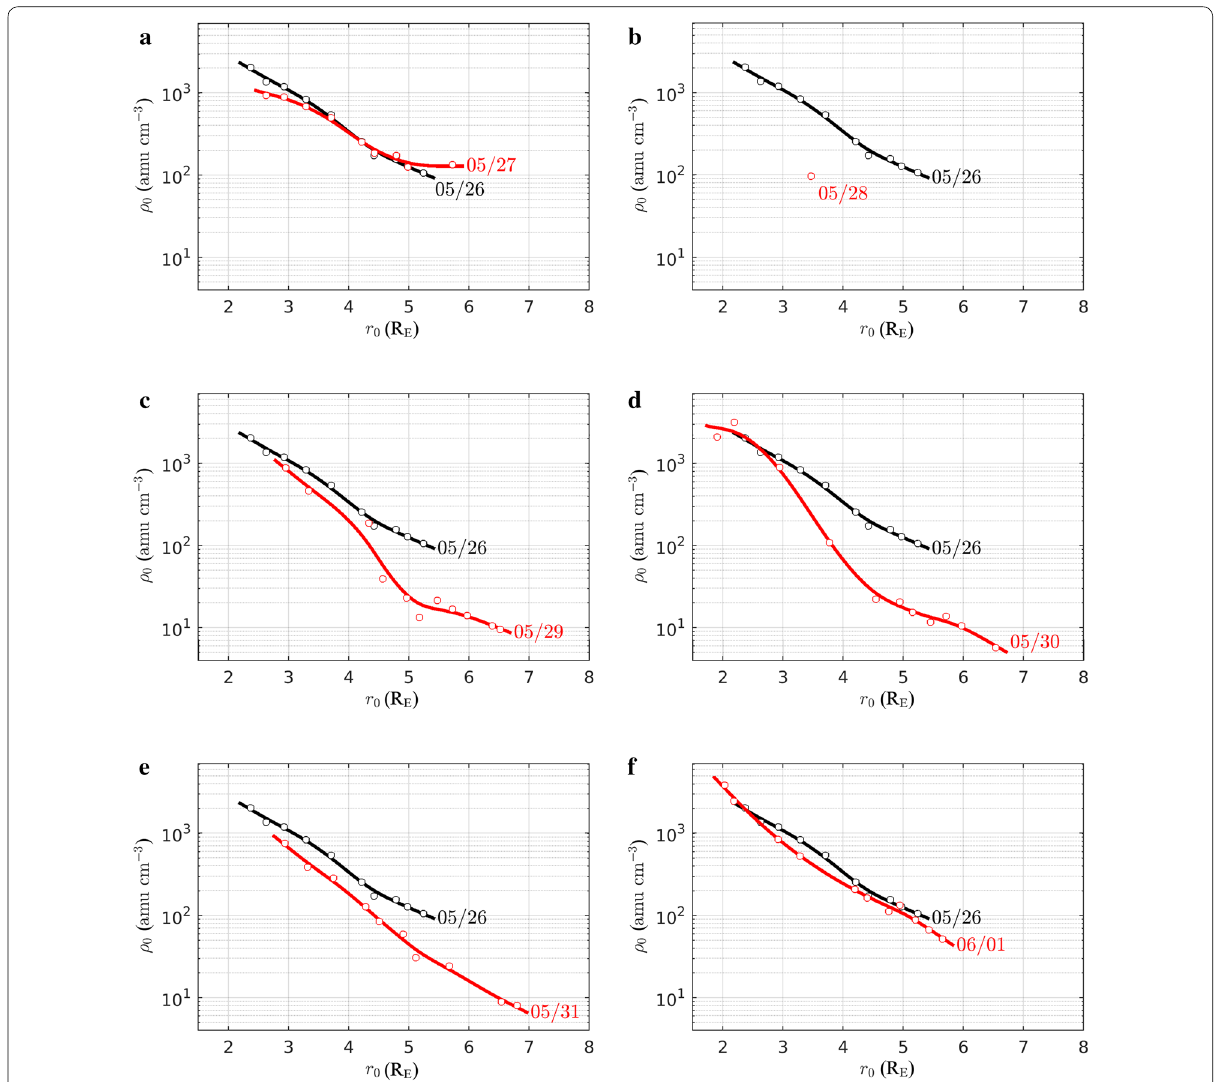
Fig. 8 Radial profile of the equatorial plasma mass density (red curve in a – f ) observed at 06:30 UT (~ 08:30 LT) between 27 May and 1 June 2017. For comparison, each panel shows also the density profile of 26 May 2017 (black curve). Solid lines are smoothed spline fits of experimental points (open